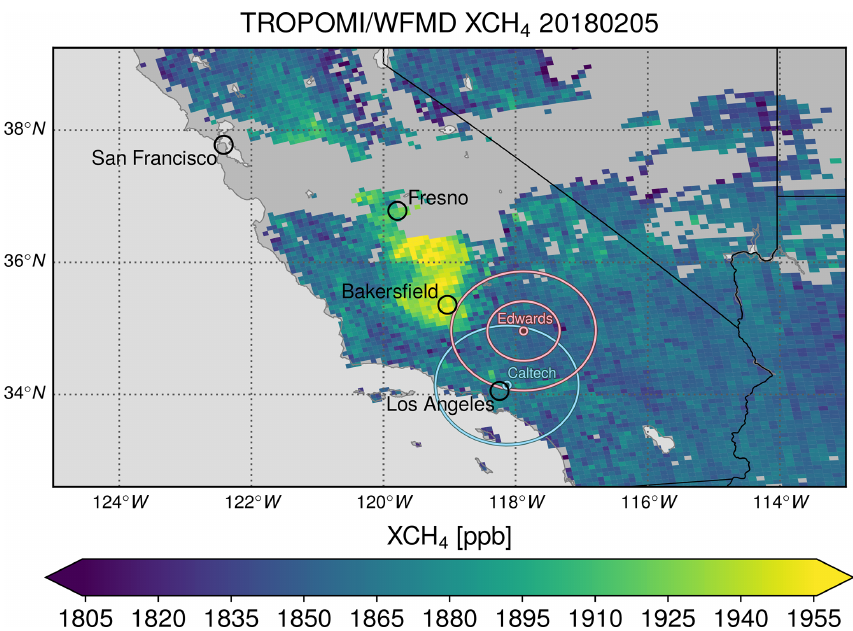
Figure 23. Methane enhancement due to anthropogenic emissions from the Californian Central Valley. In contrast to the Caltech (and JPL) TCCON site (shown in cyan), the source region is intersected by the 100km collocation radius standardly used in the validation for the Edwards site (pink). Therefore, the collocation radius is reduced to 50km for Edwards. Due to the altitude representativity criterion, different air masses are analysed in the validation at Caltech/JPL and Edwards, although the corresponding collocation circles overlap. For a discussion of the collocation criteria at Edwards and Caltech/JPL, see also Sect.